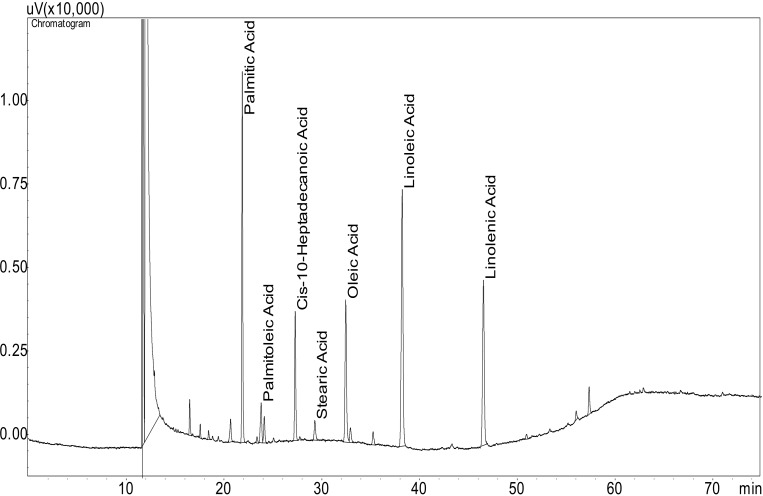
GC-FID chromatogram of FAMEs composition of microalgal biodiesel.